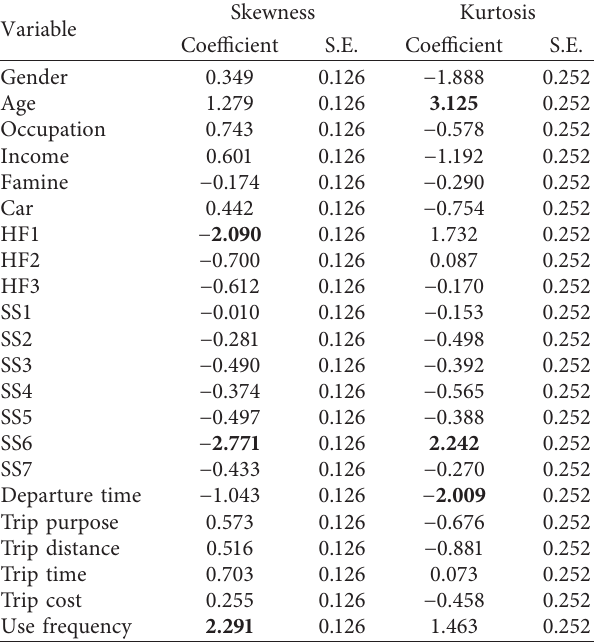
Table 4: Normality test result of the normal questionnaire.